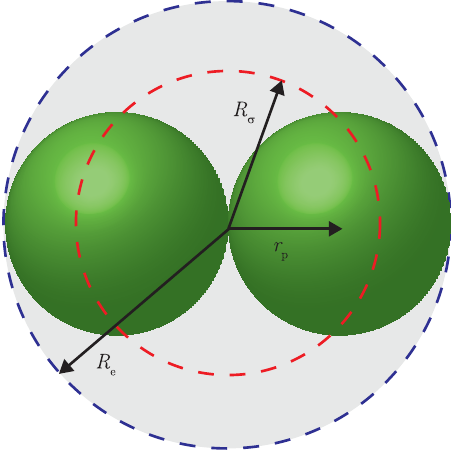
Fig. 4 Sketch of two-particle cluster with equivalent radii. Schematic drawing of a doublet together with its smallest enclosing sphere with radius R = 2 r e p (indicated by the dashed blue line) and the orientation-averaged equivalent sphere with radius R σ = 1.36 r p 38 (indicated by the dashed red